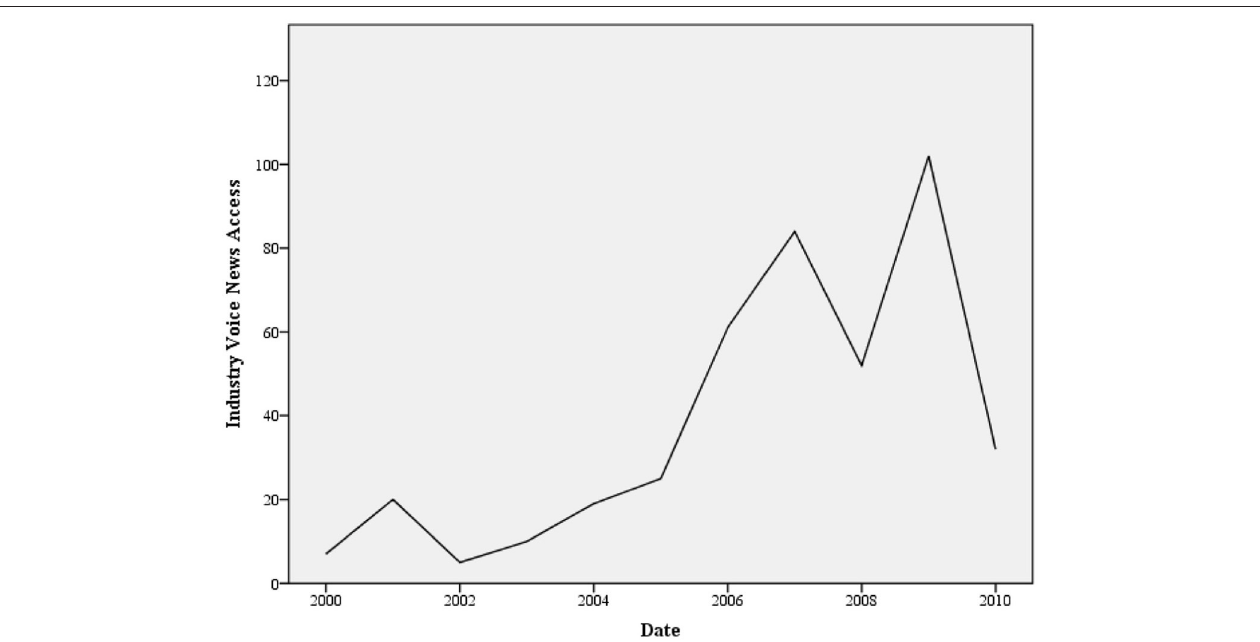
FIGURE 4 | Amount of industry news access by